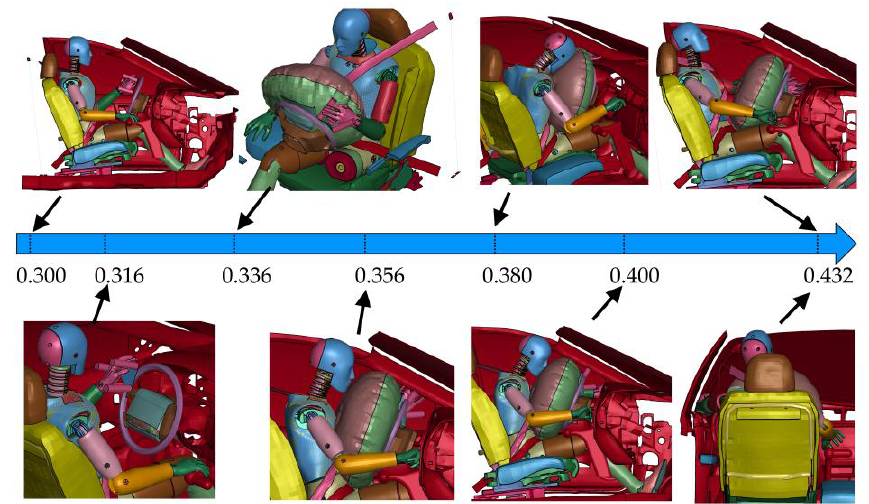
Figure 6. Characteristic time points of the simulations.